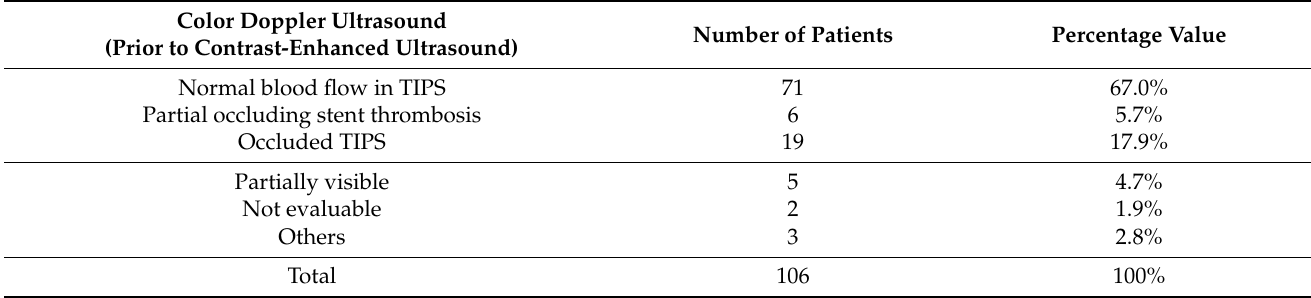
Table 1. Description of the patient cohort with regard to the results of Color Doppler ultrasound. Color Doppler Ultrasound (Prior to Contrast-Enhanced Ultrasound) Normal blood flow in TIPS Partial occluding stent